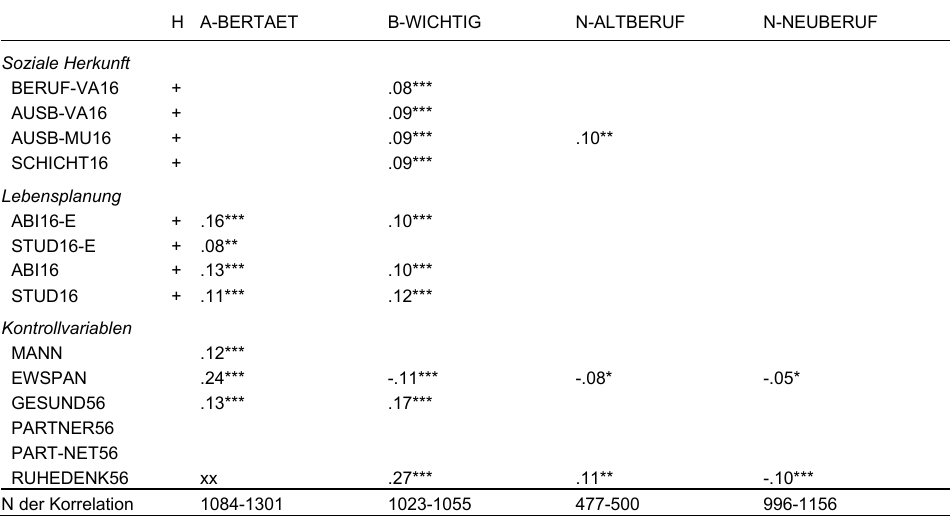
Tabelle 3 : Soziale Herkunft, Lebensplanung, Kontrollvariablen und Kontinuität